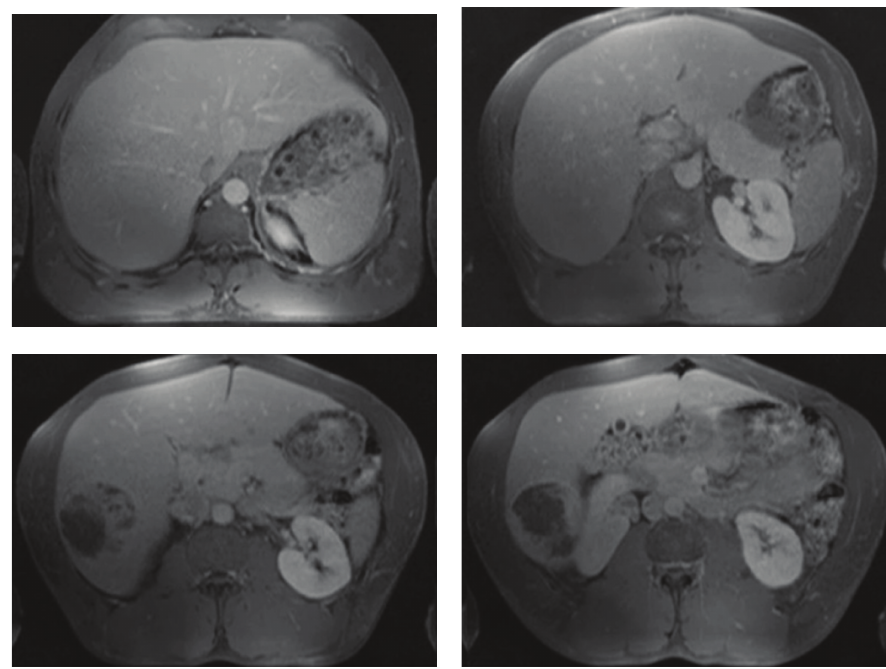
Figure 1: Magnetic resonance imaging showing the enlargement of the liver and the nonhomogeneous lesion in segment VI.